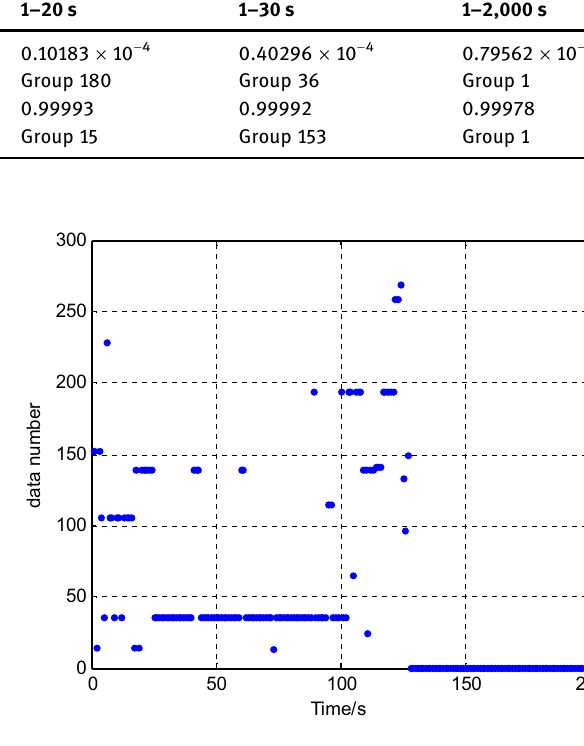
Figure 10: Identi fi cation results of trajectory matching sequence number based on fuzzy closeness.